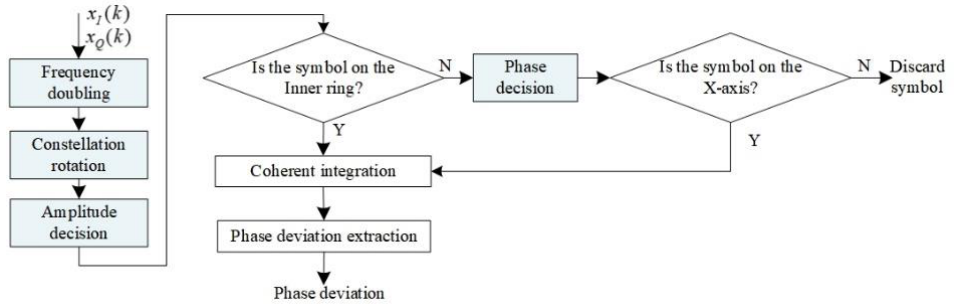
Figure 4. Diagram of the proposed carrier phase deviation discriminator.